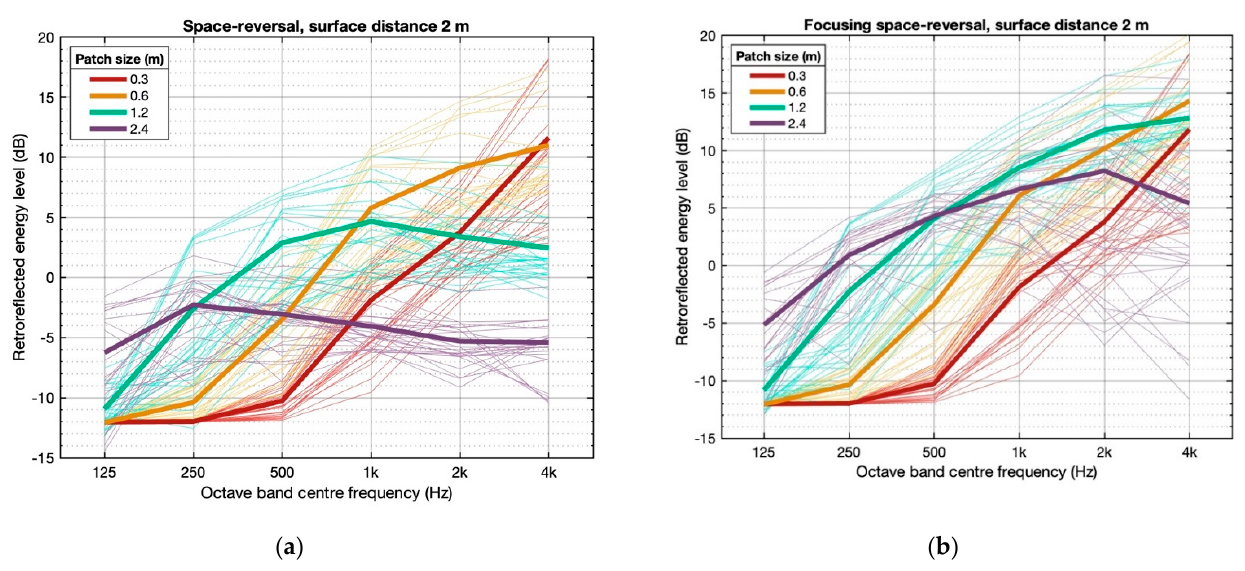
Figure 9. Octave-band distribution of retroreflected energy levels for 25 collocated source-receivers (large reflector), showing individual values (thin lines) and energetically averaged values (thick lines): ( a ) space-reversal patches ( b ) focusing space-reversal patches.